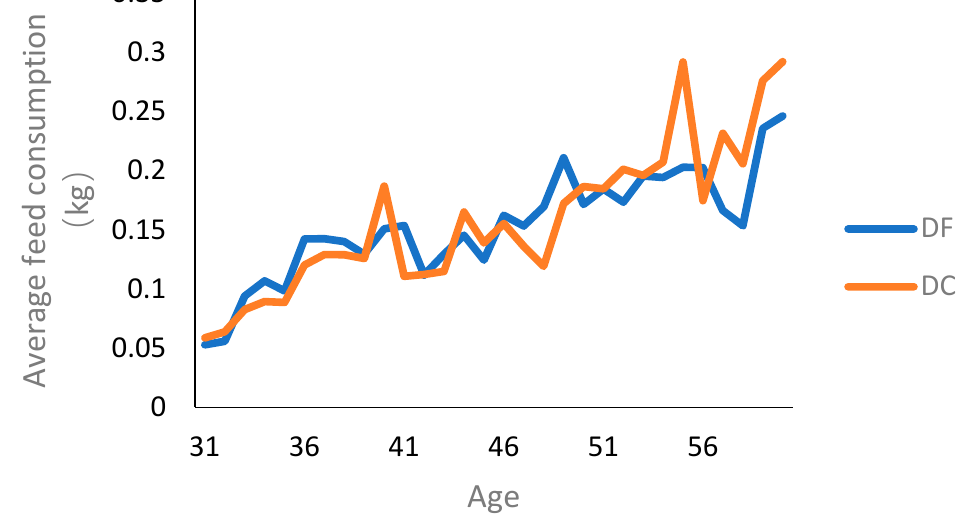
Figure 2. Feed consumption of ducks between DC and DF groups. DC: ducks kept within the combination of planting and breeding; DF: ducks kept in free range.